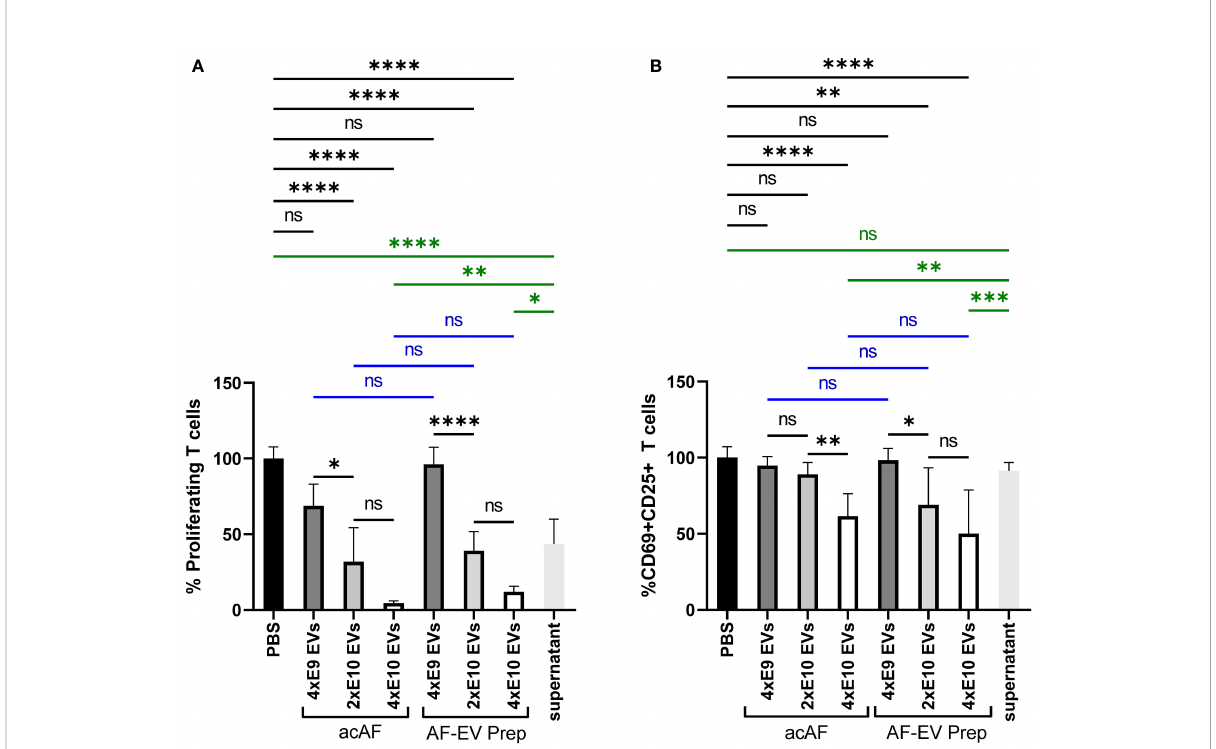
FIGURE 5 AF-EVs Have a Dose-Dependent Suppressive Effect on T Cell Proliferation and T Cell Activation PBMCs were stimulated with PHA and treated with either PBS, doses of acAF, doses of AF-EV Preparation, or EV-depleted acAF supernatant (A) Proliferating T cells treated with PBS or different doses of acAF or AF-EV Preparation following PHA stimulation were graphed as a percentage of proliferating T cells in PBS treated control group. (B) CD69+CD25+ T cells treated with PBS or different doses of acAF or AF-EV Preparation following PHA stimulation were graphed as a percentage of CD69+CD25+ T cells in PBS treated control group. (Data graphed as mean ± SD; One way ANOVA with Tukey ’ s test; Blue= equivalent dose comparisons between acAF and AF-EV Prep; Green= comparisons with EV-depleted supernatant; n=3 for each group; ns=not signi fi cant; *=p<.05; **=p<.01; ***=p<.001; ****=p<.0001; Data is derived from 3 separate experiments. Each experiment used 1 independent PBMC donor treated with 1 of 3 acAF donors, 1 of 3 AF-EV donors, and 1 of 2 EV-depleted supernatant